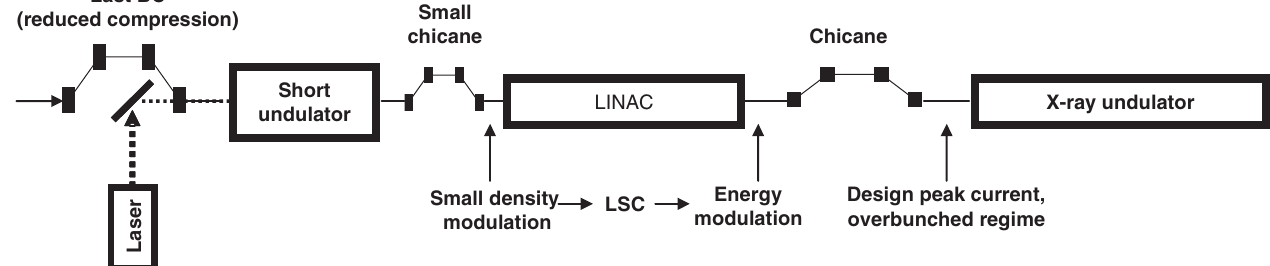
FIG. 2. Conceptual scheme for stabilization of SASE FEL operation.